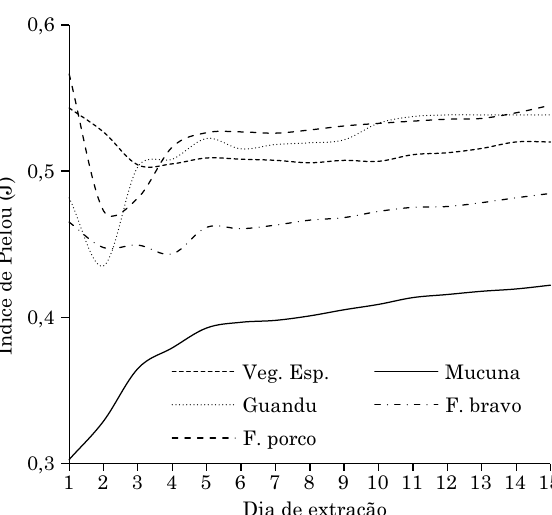
Figura 7. Variação diária do índice de Pielou (J), em razão da quantidade de organismos capturados, discriminada por tratamentos [feijão-de-porco ( Canavalia ensiformis ), mucuna-preta ( Mucuna aterrima ), feijão-bravo-do-Ceará ( Canavalia brasiliensis ), guandu ( Cajanus cajan ) e vegetação espontânea], referente à segunda coleta.